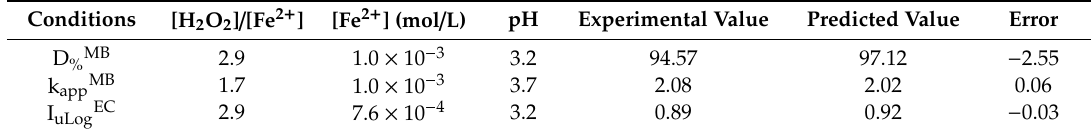
Table 5. Results of validation experiments under optimized